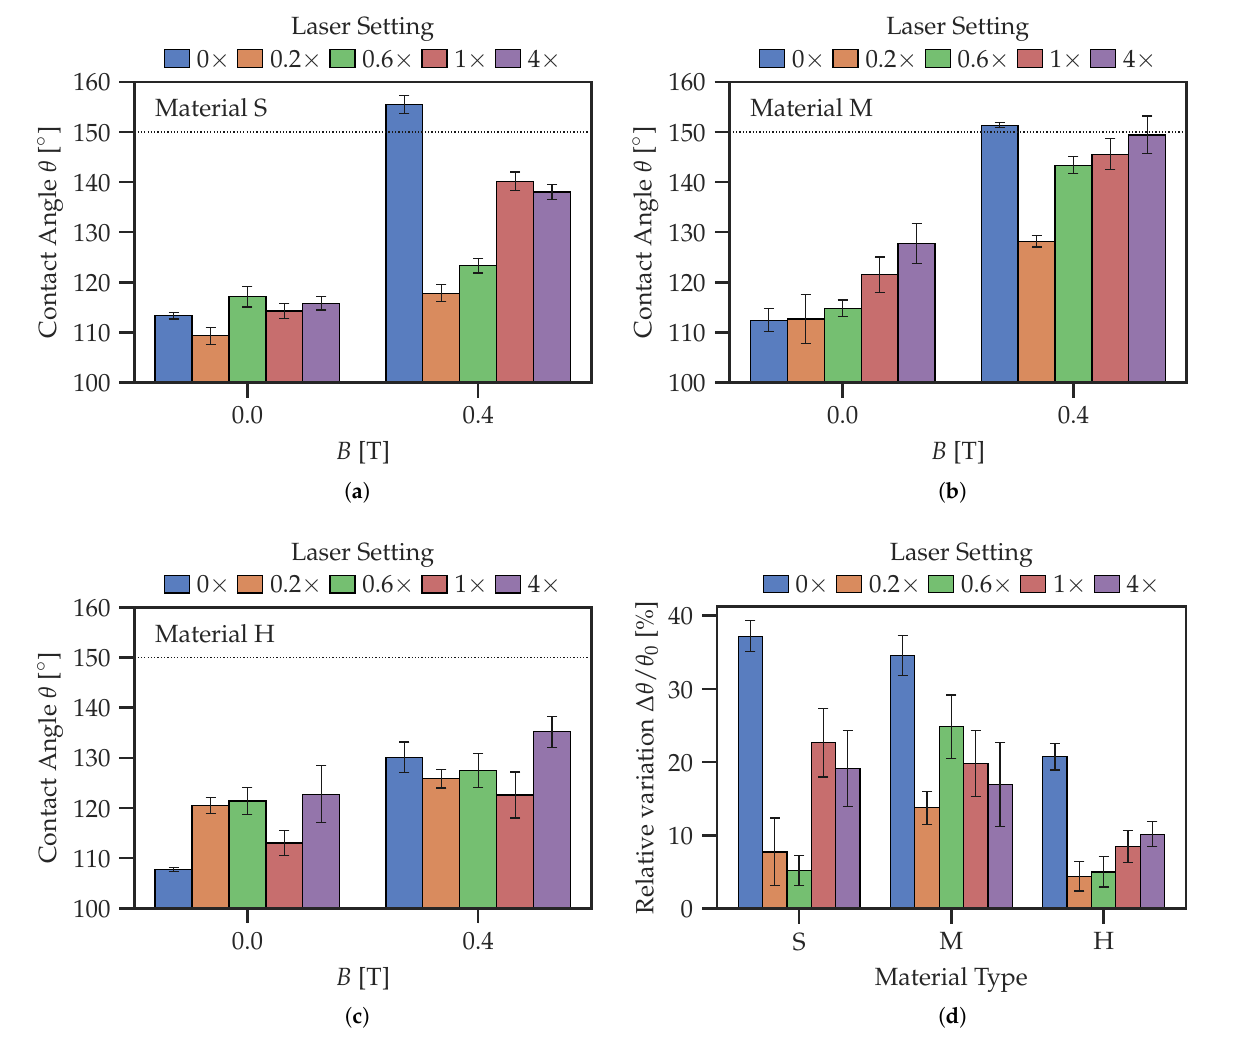
Figure 10. Comparison of contact angles on laser treated MAE surfaces for different laser power settings. ( a ) Material S; ( b ) Material M; ( c ) Material H. ( d ) Relative change in the contact angle ∆ θ / θ 0